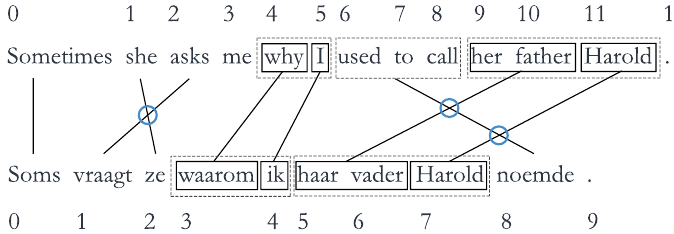
Figure 3. Example of SACr, with a SACr value of 3/8 = 0.375 (example taken from Vanroy et al. [21]). The dotted boxes indicate word groups that are not linguistically motivated; they are simply words that remain in the same order in the translation. These boxes are then split into linguistically motivated groups (solid boxes) to calculate SACr. (Literal translation of Dutch sentence: * Sometimes asks she why I her father Harold used to